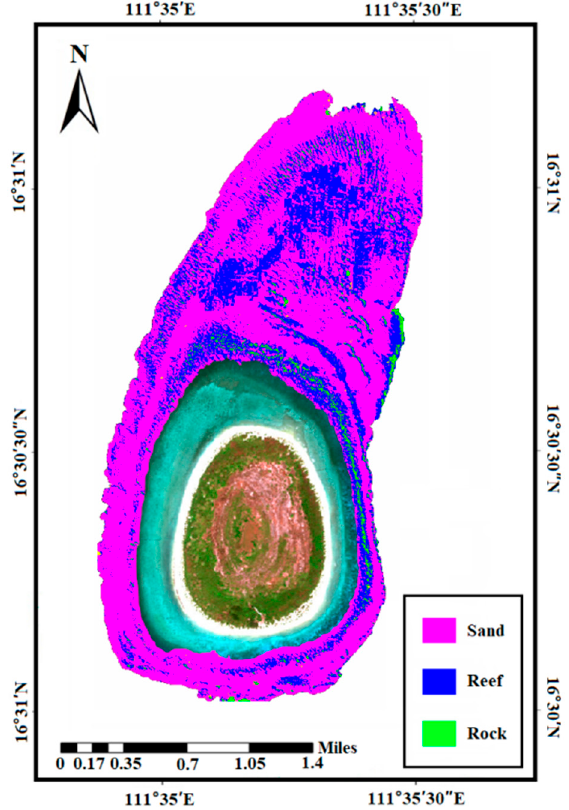
Figure 10. Overall classification results of the survey area based on seafloor.